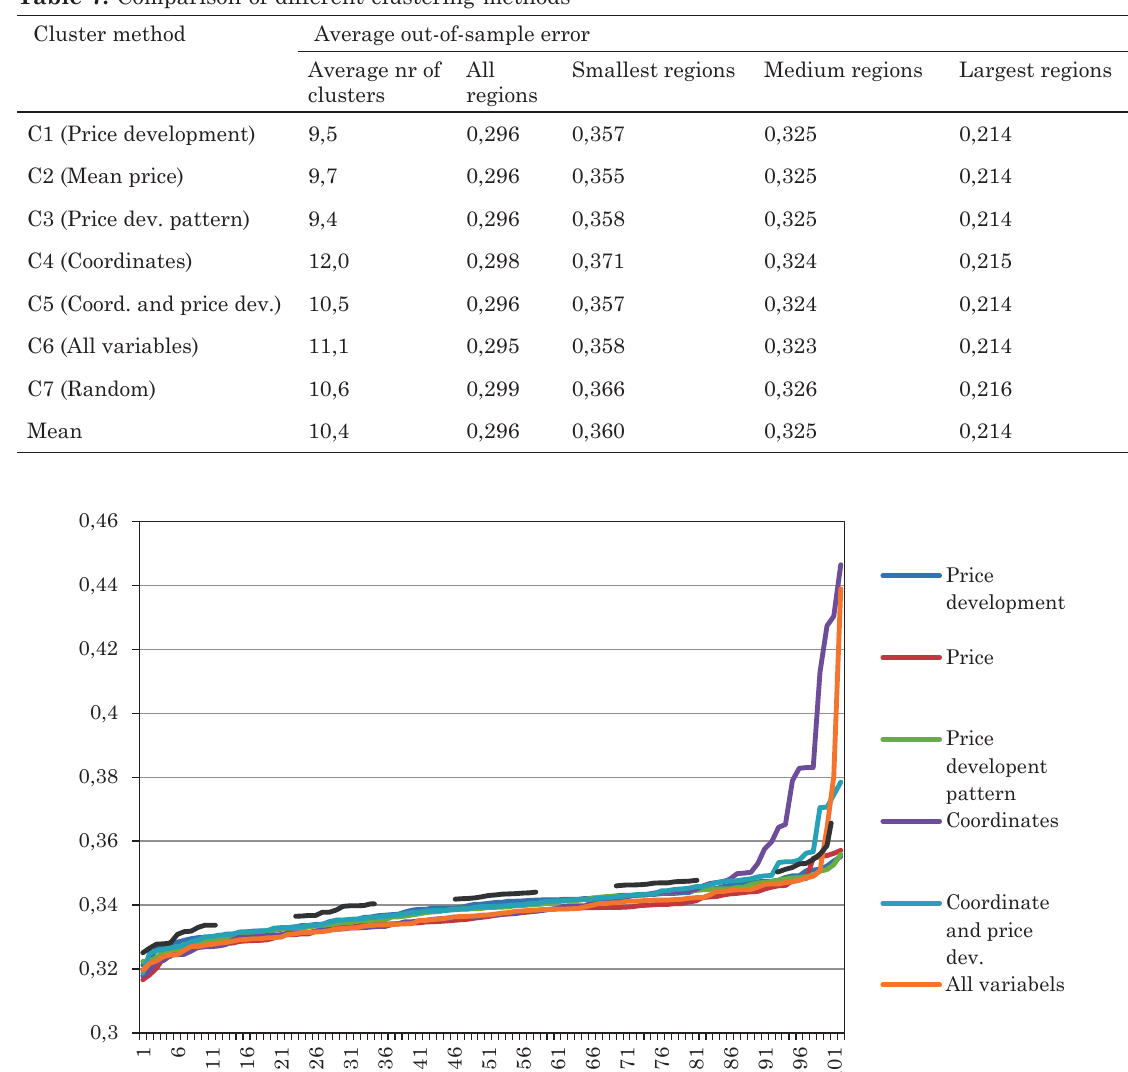
Table 7. Comparison of different clustering methods Cluster